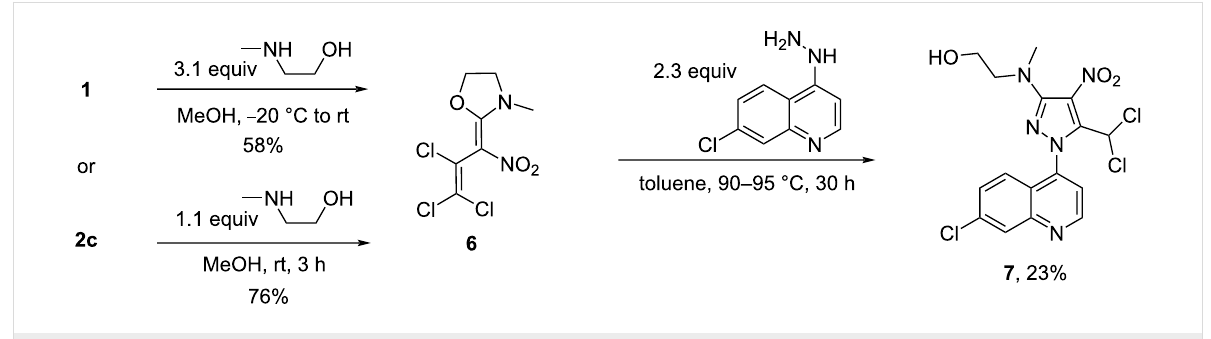
Scheme 5: Synthesis of oxazolidine 6 and pyrazole 7 .